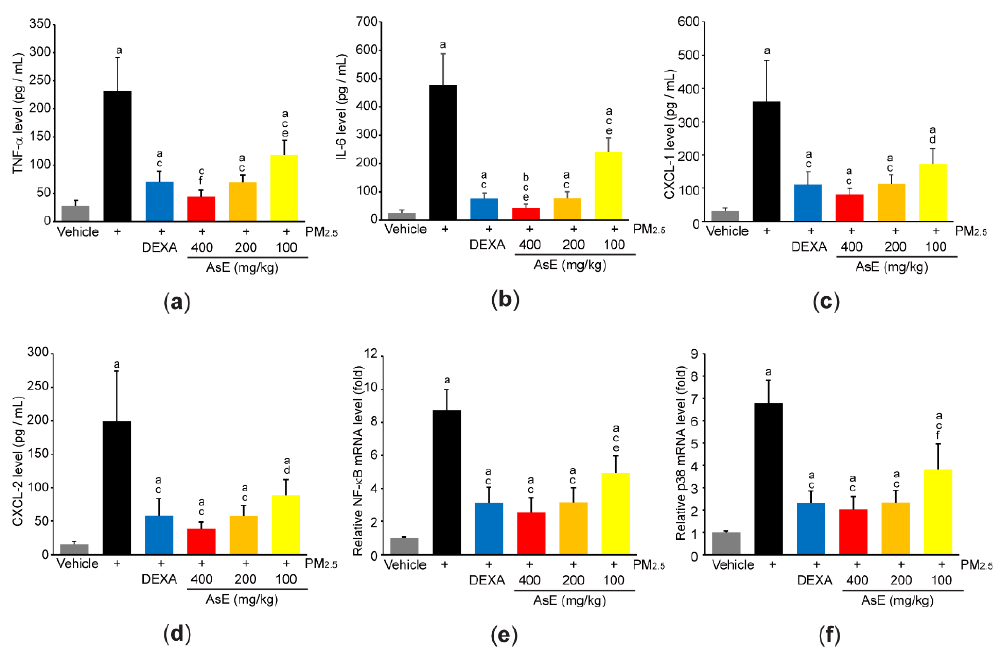
Figure 6. AsE decreases the production of inflammatory mediators in the lungs. ( a – d ) Protein levels of TNF- α ( a ), IL-6 ( b ), CXCL-1 ( c ), and CXCL-2 ( d ) were quantified by ELISA. ( e , f ) mRNA levels of NF- κ B ( e ) and p38 ( f ) were quantified by qPCR. a p < 0.01, b p < 0.05 versus vehicle group; c p < 0.01, d p < 0.05 versus PM 2.5 group; e p < 0.01, f p < 0.05 versus PM 2.5 + DEXA group; TNF- α , tumor necrosis factor α ; IL, interleukin; CXCL, C-X-C motif chemokine ligand.